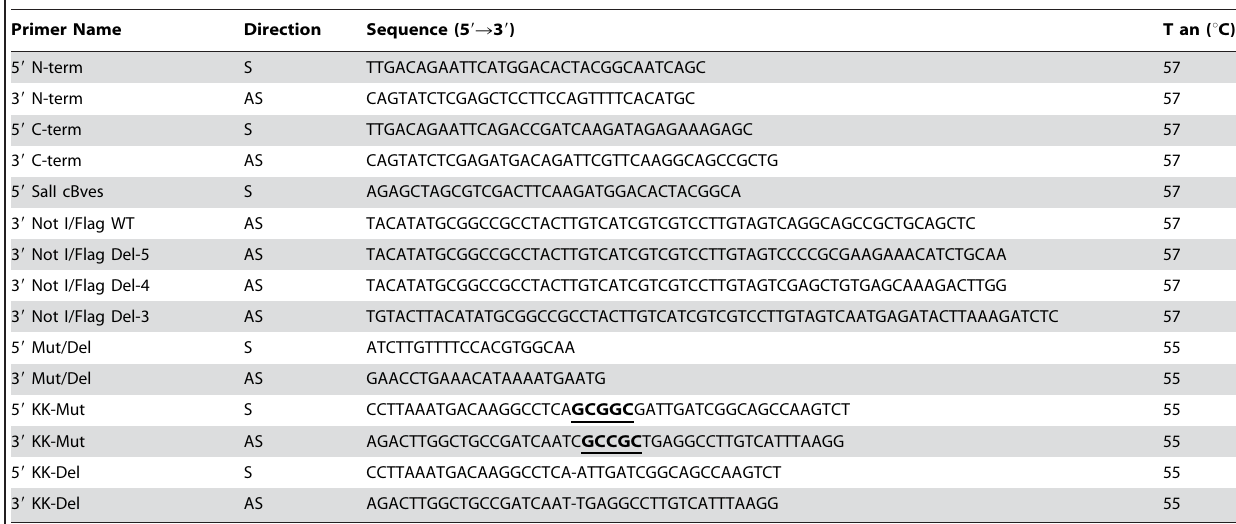
Table 1. Sequences of primers used to generate Bves constructs